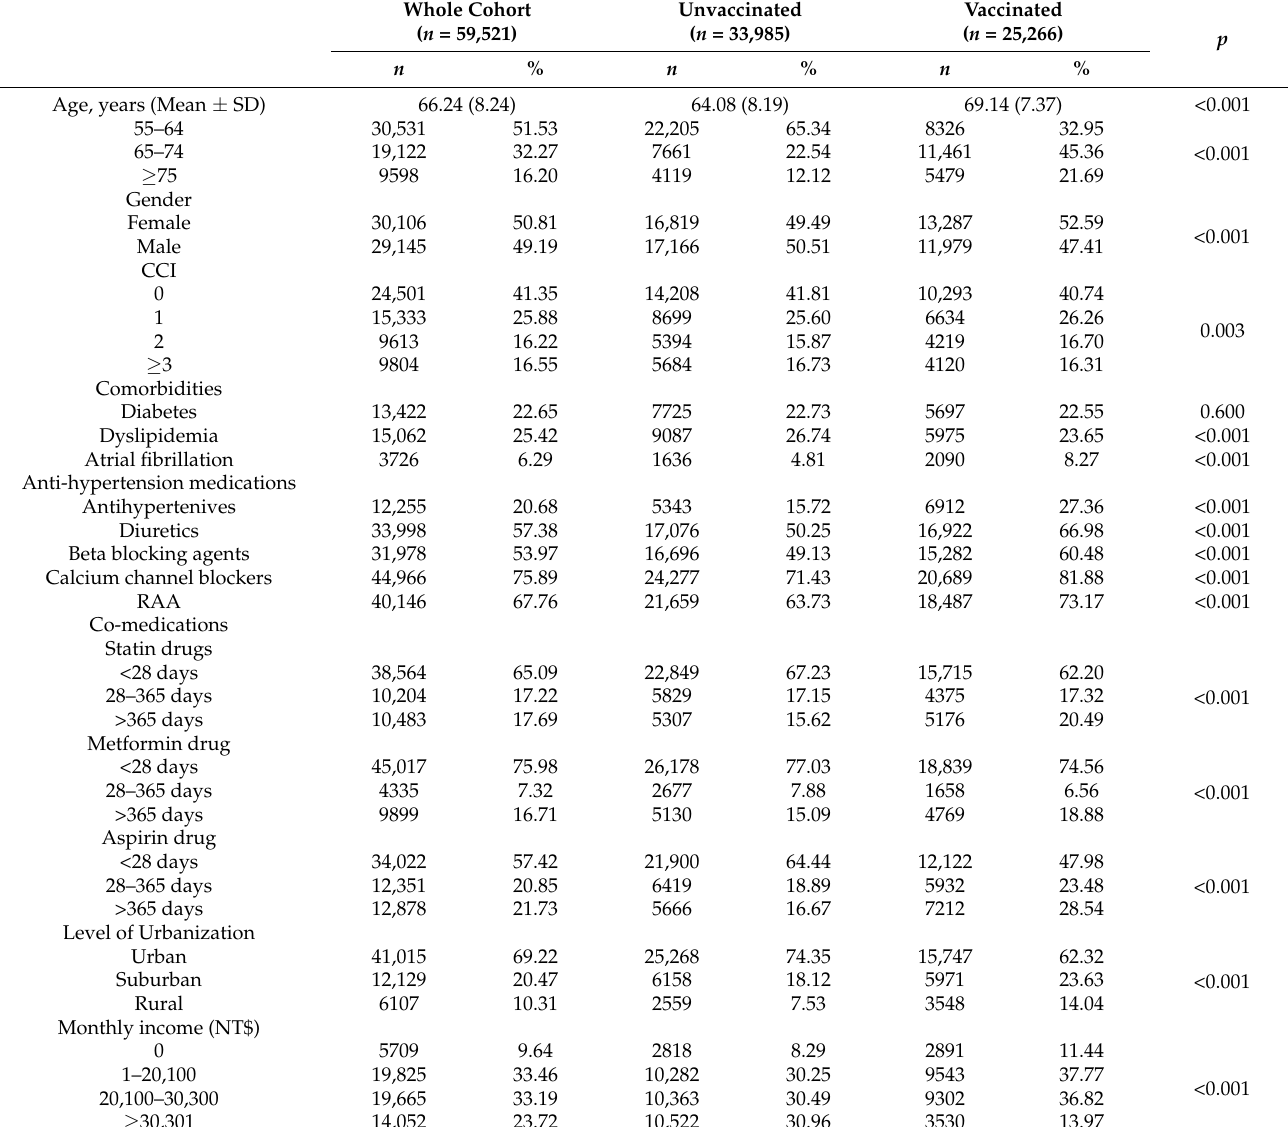
Table 1. Characteristics of the Sample